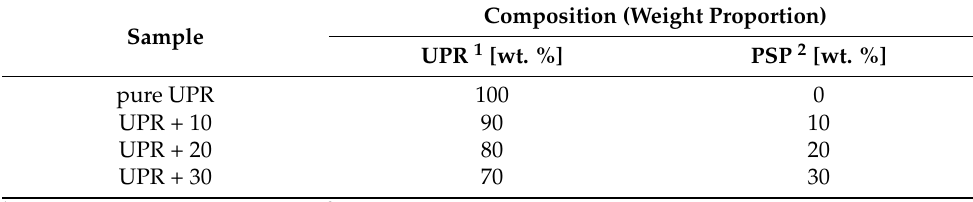
Table 1. Formulation of UPR/PSP composites. Sample